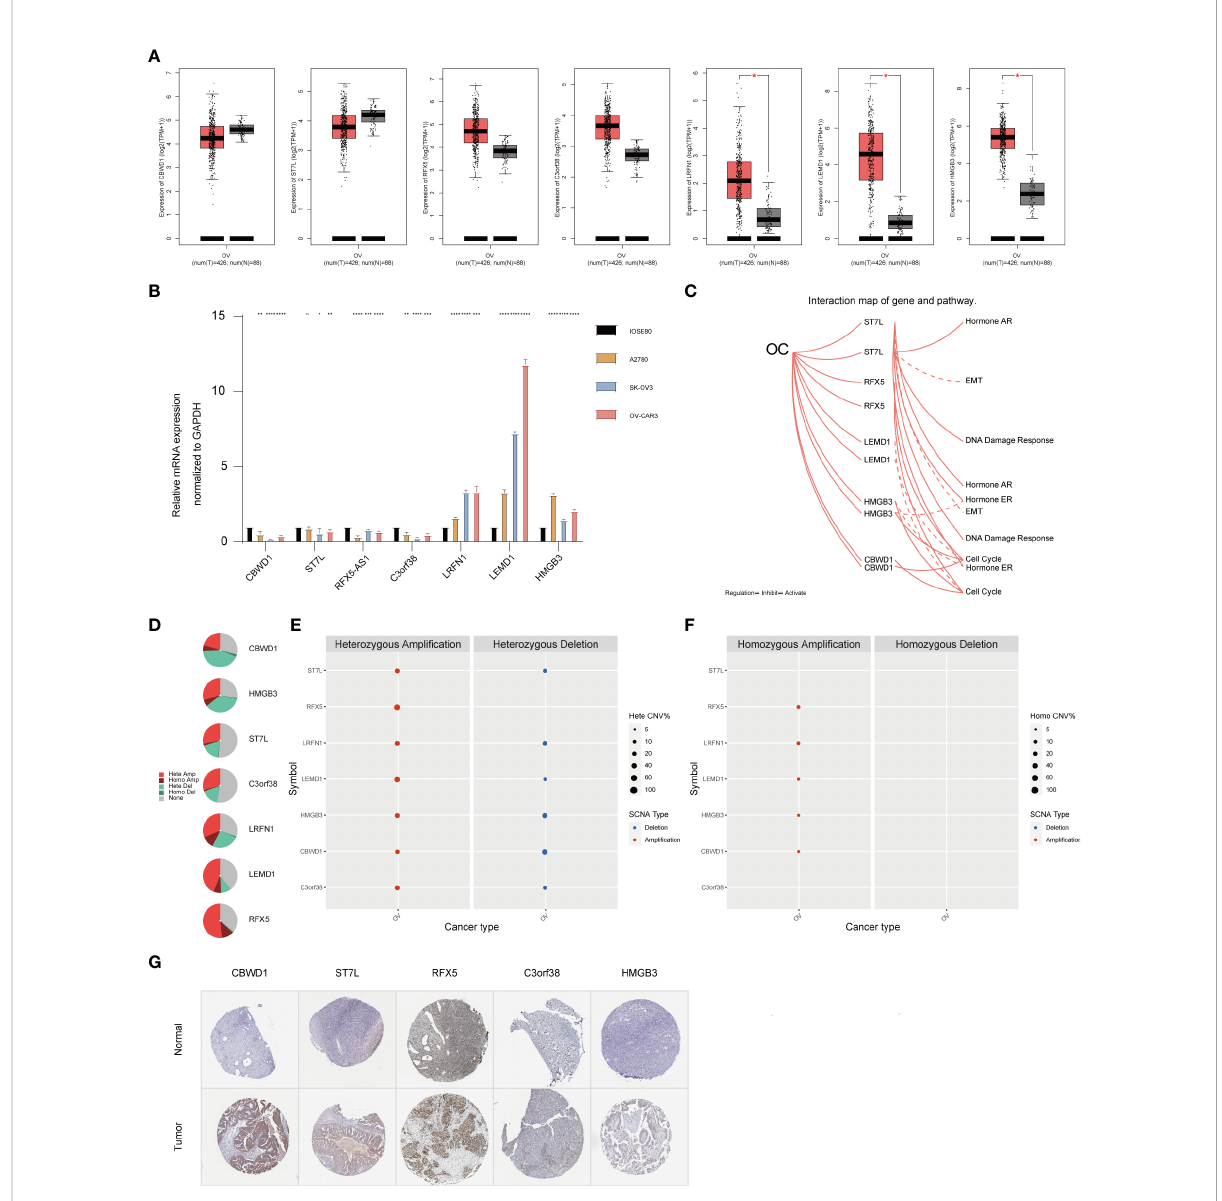
FIGURE 7 Expression pattern validation and relevant biological functions of hub genes in OC. (A) Expression pattern of CBWD1, ST7L, RFX5, C3orf38, LRFN1, LEMD1, and HMGB3 in OC and normal samples from the GEPIA database. (B) RT-QPCR analysis of CBWD1, ST7L, RFX5-AS1, C3orf38, LRFN1, LEMD1, and HMGB3. (C) Related signaling pathways of ST7L, RFX5, LEMD1, HMGB3, and CBWD1 in OC. (D – F) CNV of CBWD1, ST7L, RFX5, C3orf38, LRFN1, LEMD1, and HMGB3 in OC from the GSCA Lite database, including heterozygous (E) and homozygous (F) CNV.